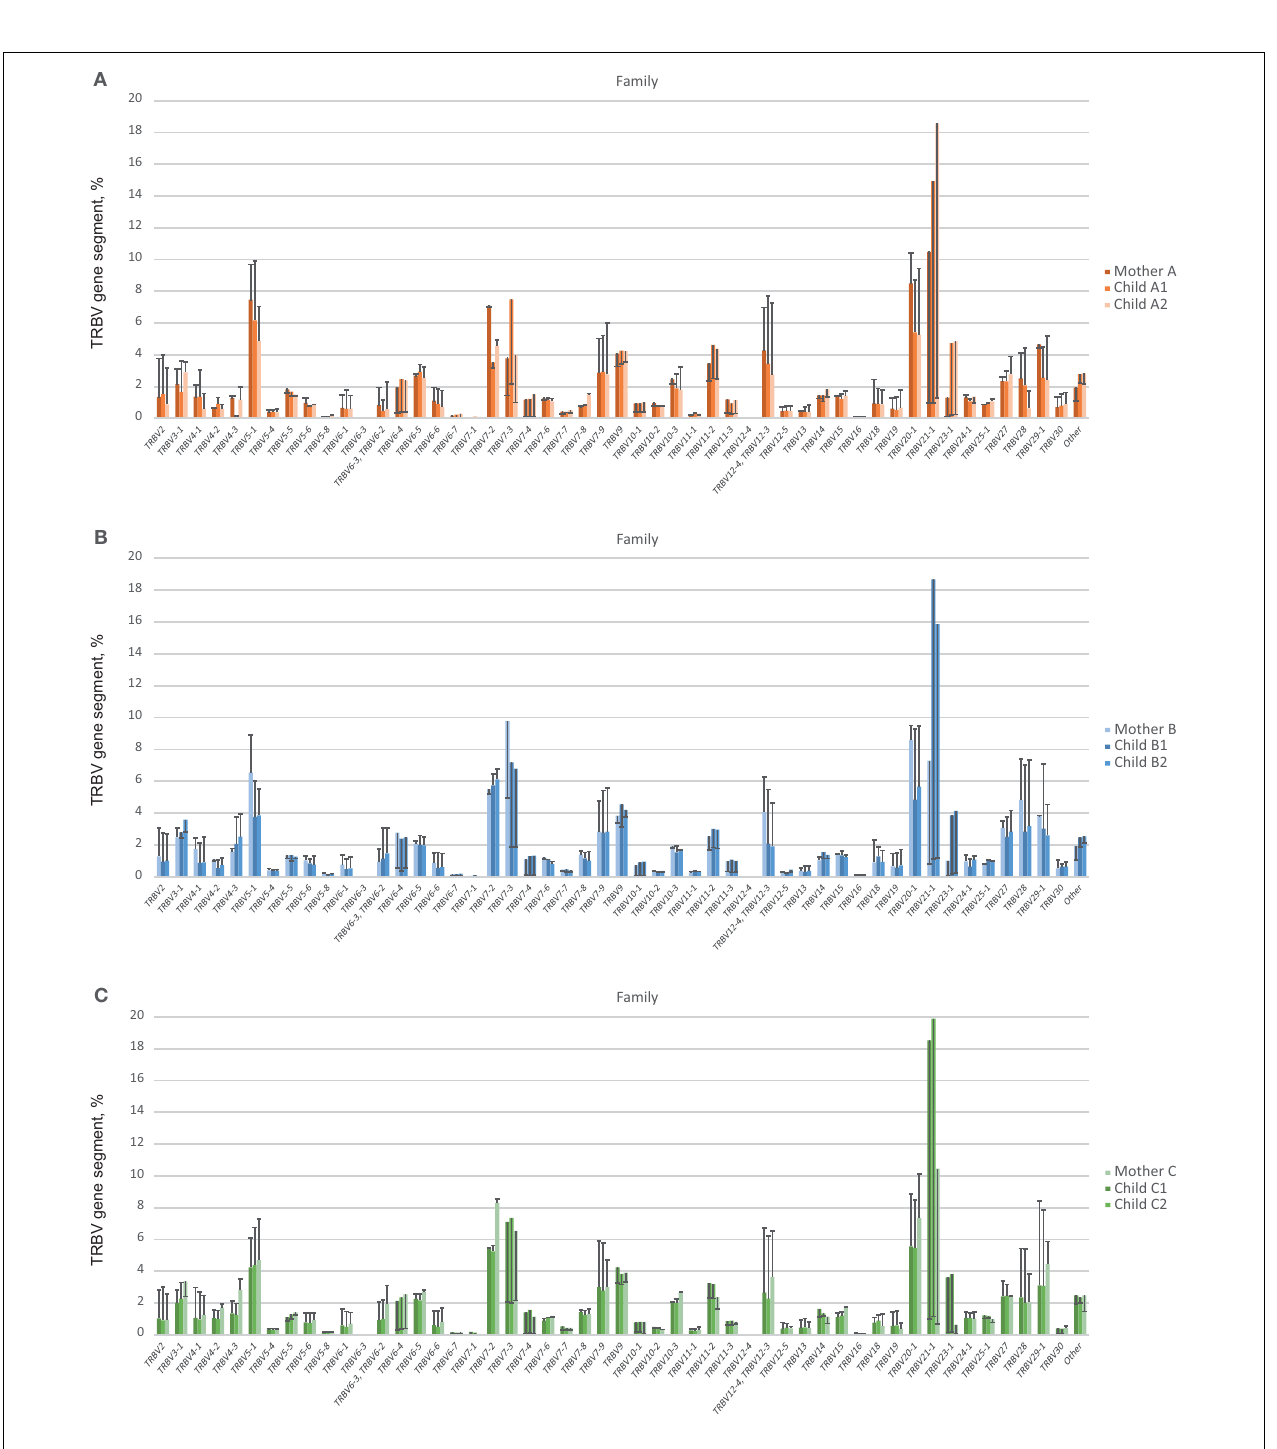
TRBV gene segment representation in functional low-frequencyTCR beta clonotypes relative to out-of-frameTCR variants. (A) , (B) , and (C) depictTRBV gene segment usage for related donors from family (A) , (B) , and (C) , respectively.